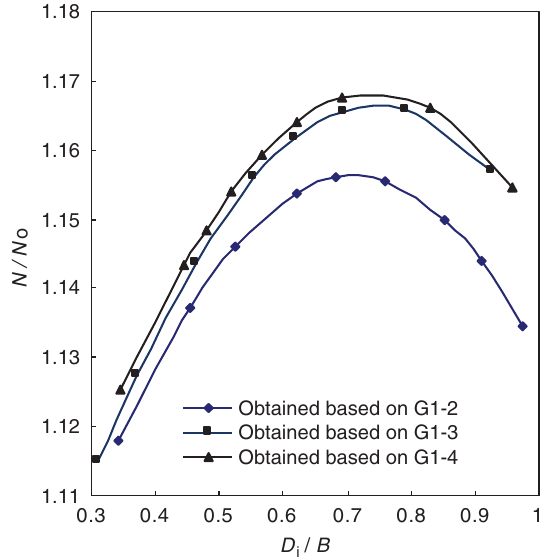
Fig. 6. Predicted axial load ( N / N 0 ) versus D i /B interaction